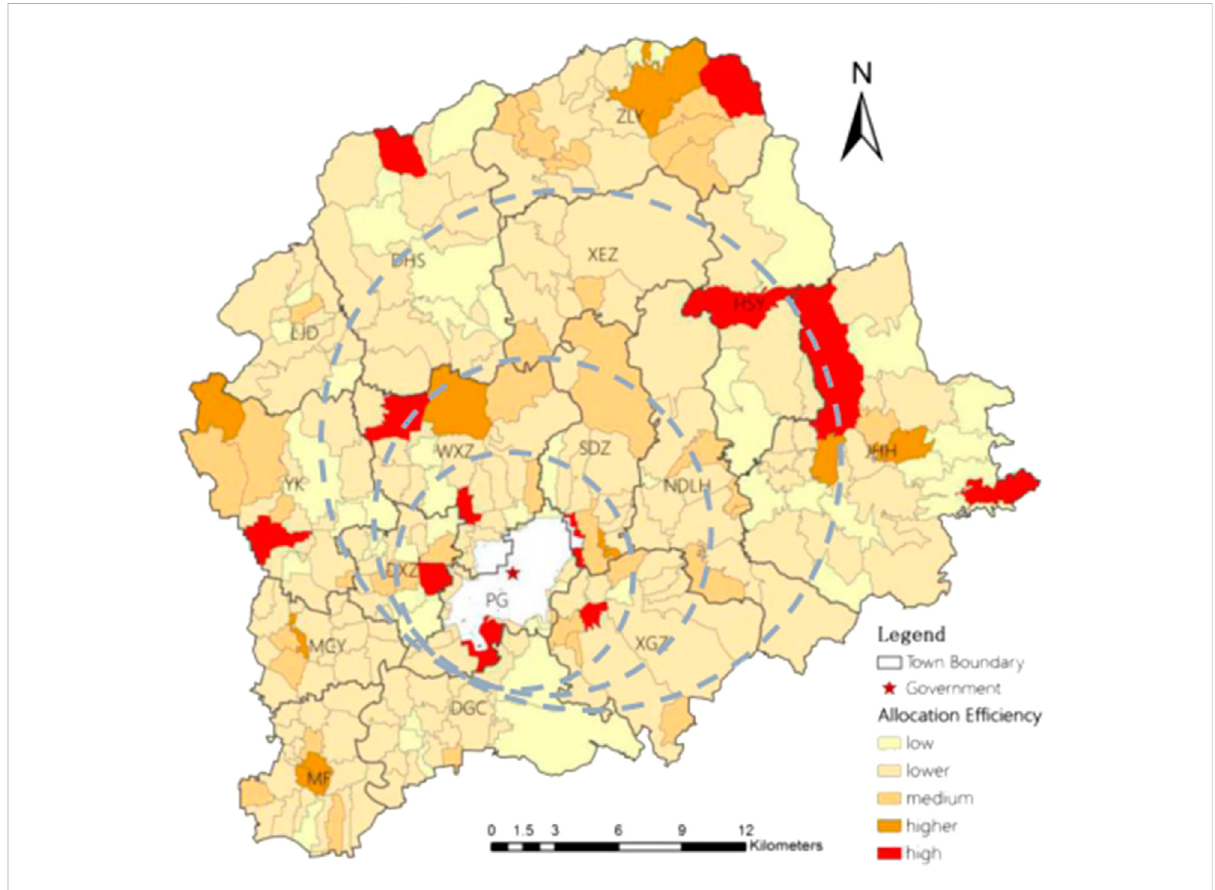
FIGURE 5 The allocation ef fi ciency of RPSL in